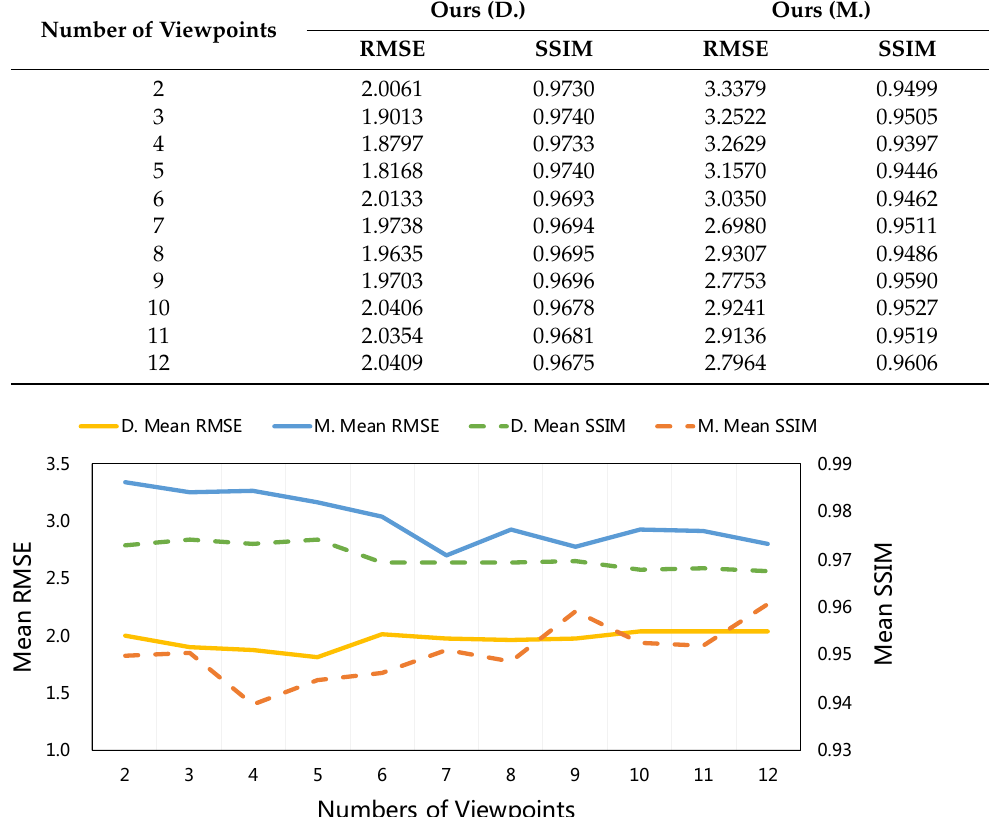
Table 4. Quantitative evaluation of the experiment on the number of viewpoints on the Laboratory Captured Dataset.